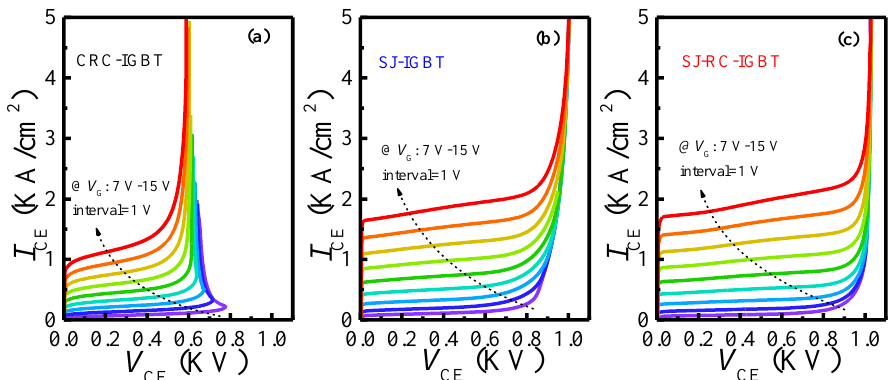
Figure 6. I-V characteristics of three IGBTs with a ramp-up V G from 7 V to 15 V(The lines from blue-purple to red indicate increase in V G from 1V to 5V with 1 V interval.): ( a ) I-V characteristics of CRC-IGBT, ( b ) I-V characteristics of SJ-IGBT, and ( c ) I-V characteristics of SJ-RC-IGBT.